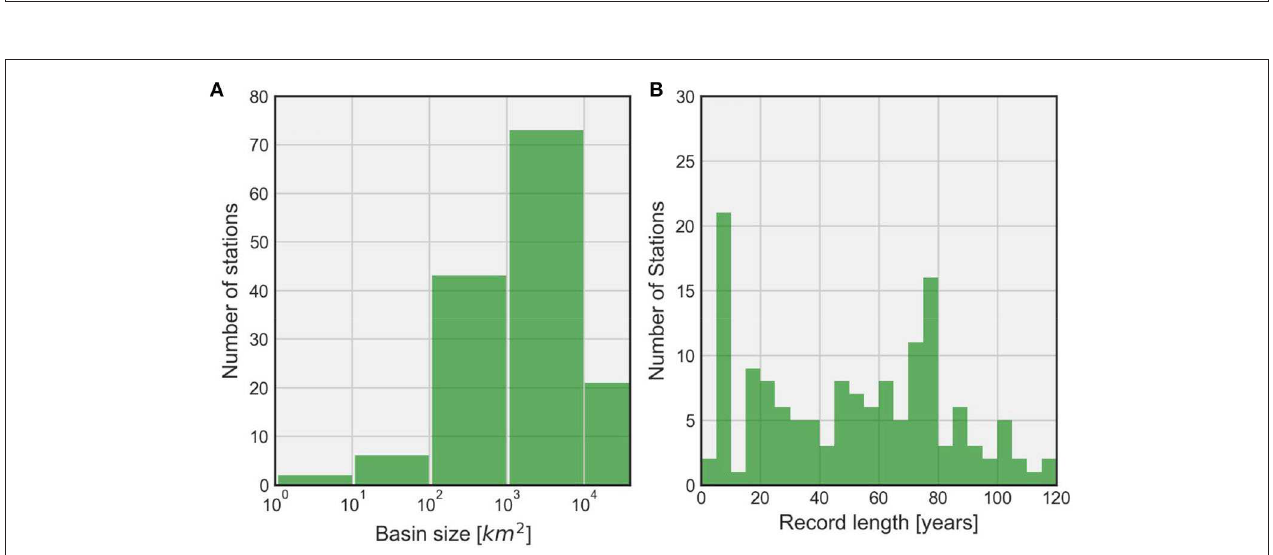
FIGURE 3 | Histogram of USGS basin characteristics. (A) Distribution of basin scales across Iowa; (B) distribution of streamflow record lengths in terms of number of stations.